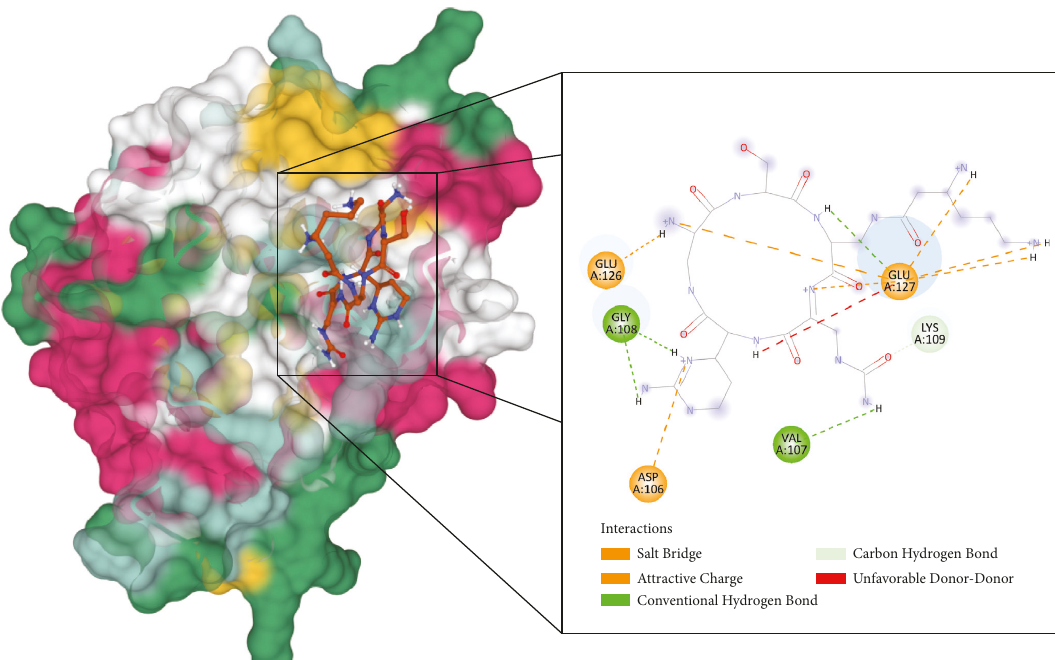
Figure 2: The interaction of capreomycin toward the HpTlyA protein predicted by molecular docking.